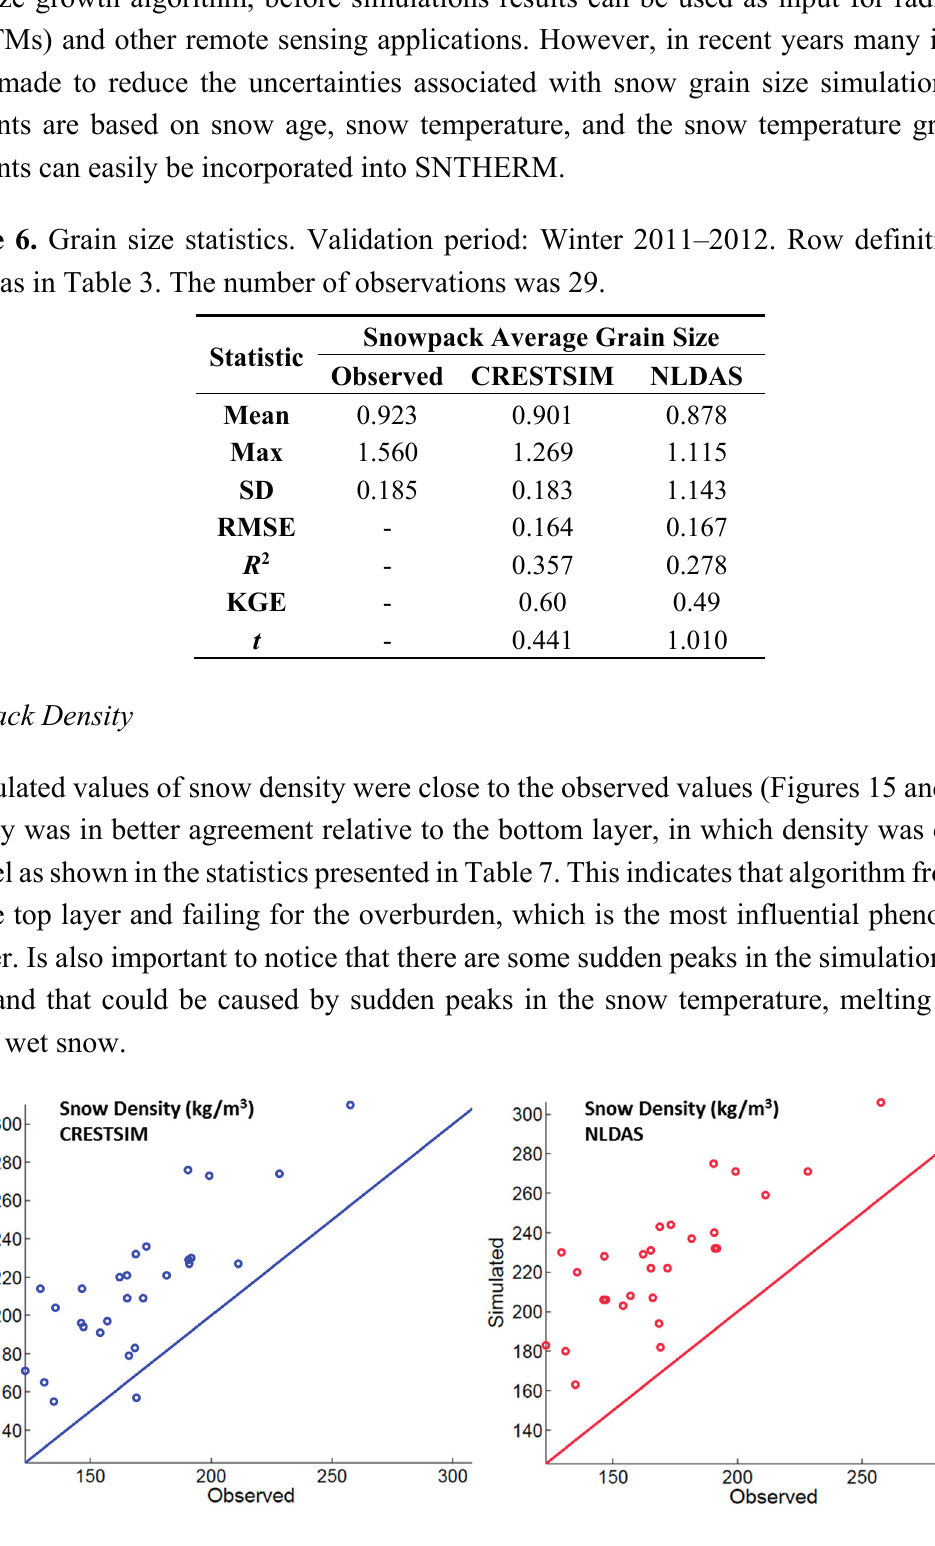
Figure 15. Average snow density scatter plot (winter 2011–2012) for both simulated scenarios: ( left ) CRESTSIM and ( right )